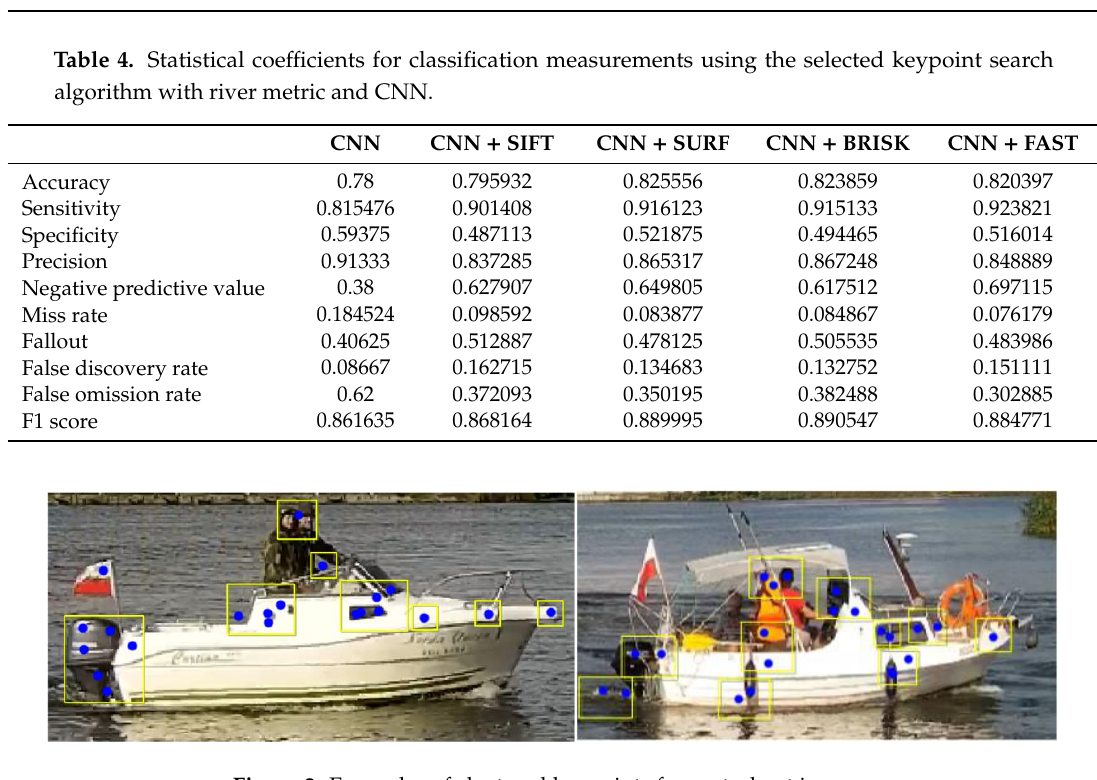
Table 4. Statistical coefficients for classification measurements using the selected keypoint search algorithm with river metric and CNN. CNN